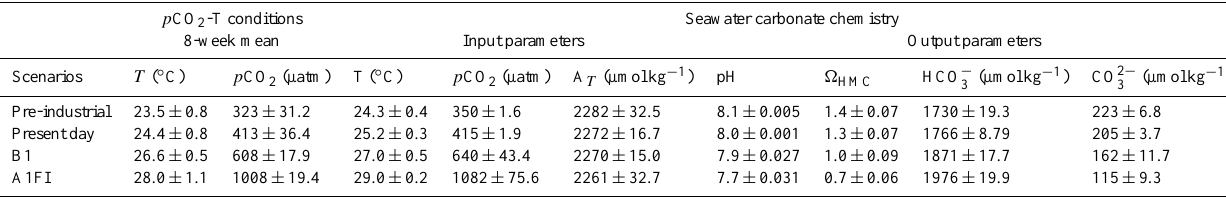
Table 1. Summary of the physical and chemical seawater parameters kept over 8 weeks to create four distinct p CO 2 -T scenarios, along with the carbonate chemistry estimated for each p CO 2 -T scenario at the end of the experiment. Temperature and p CO 2 are mean values ( ± SD) recorded at < 30min intervals over the length of the experiment. Input temperature ( T ), seawater p CO 2 , and total alkalinity ( A T ) are means ( ± SD) of 18 seawater replicates collected at the end of the study. Output pH (seawater scale kg mol − 1 ), bicarbonate (HCO − and carbonate (CO 2 − ) were estimated using the program CO2SYS (Pierrot et al., 2006). HMC saturation state ( (cid:127) HMC ) was estimated for 3 a 17%mol magnesite (MgCO 3 ) content as described in Diaz-Pulido et al. (2012). p CO 2 -T